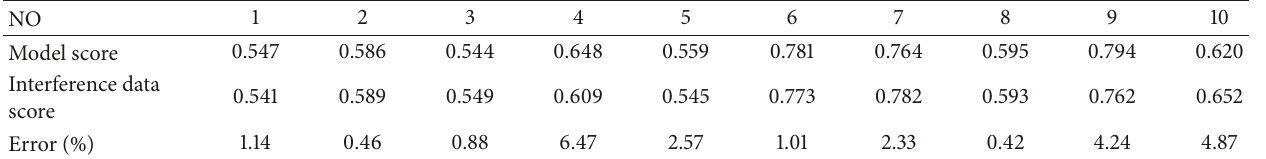
Table 14: Error test of interference data score and model